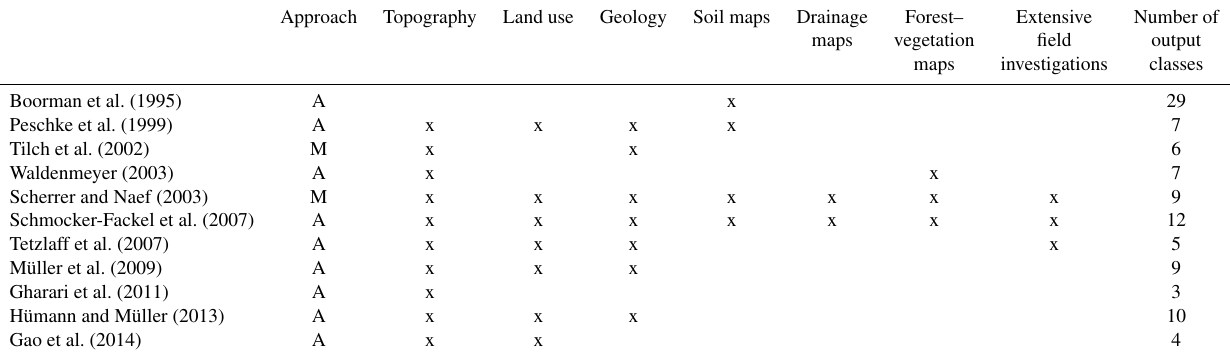
Table 1. List of hydrological classifications based on DRPs, the data they require, and the number of output classes (A: automatic; M: manual). Approach Topography Land use Geology Soil maps Drainage Forest– Extensive Number of maps vegetation field output maps investigations